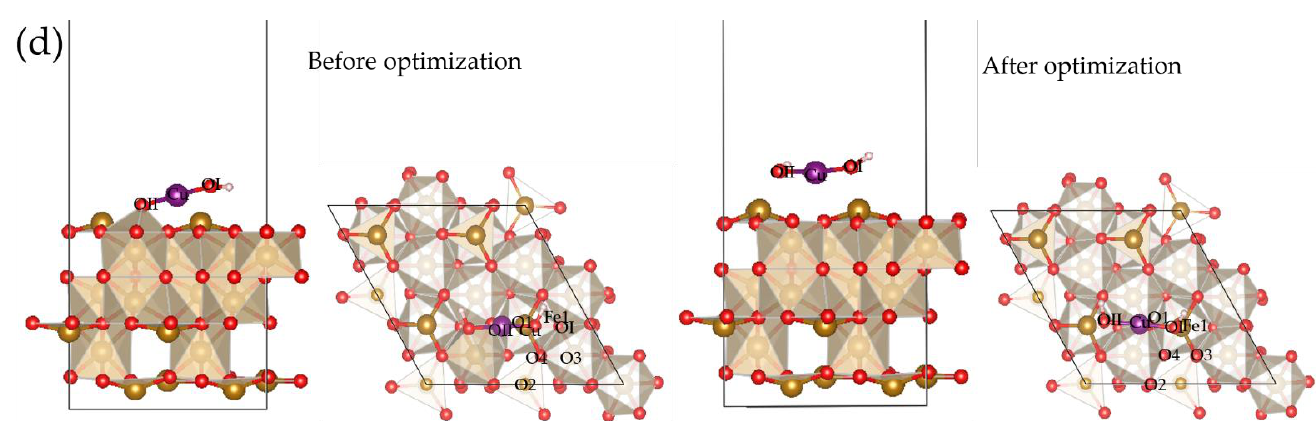
Figure 2. The specularite (0 0 1) surface models with original and various Cu species adsorption before and after optimization: ( a ) original, ( b ) Cu 2+ , ( c ) Cu(OH) + , ( d ) Cu(OH) 2 .